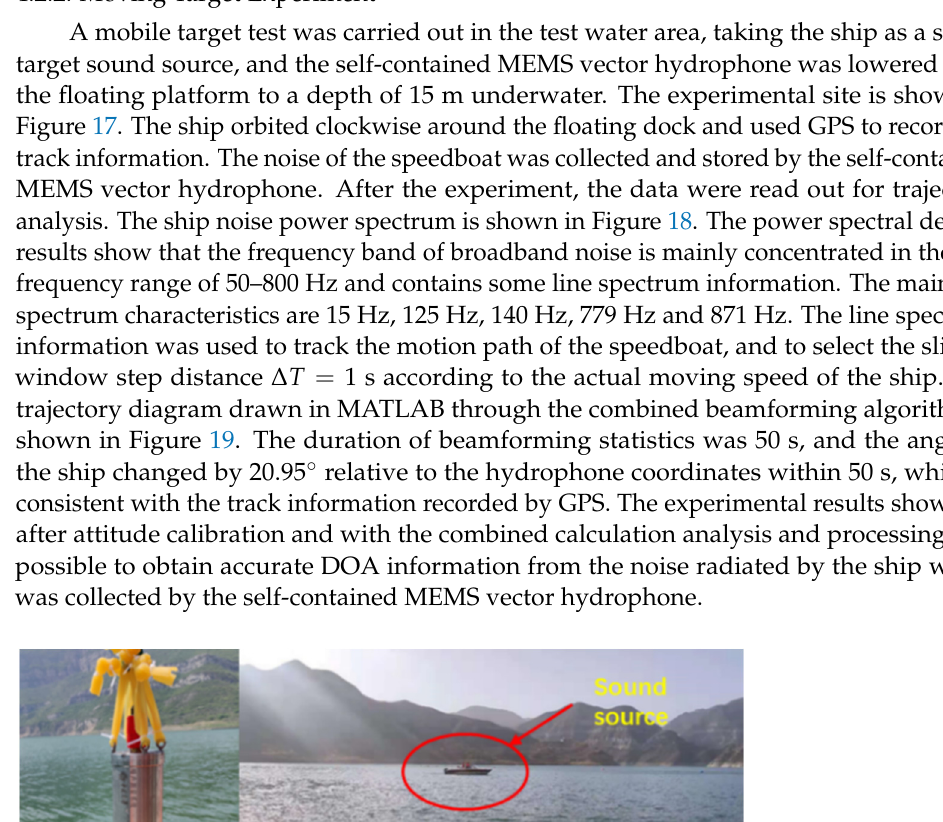
Figure 16. Direction of arrival estimation results.